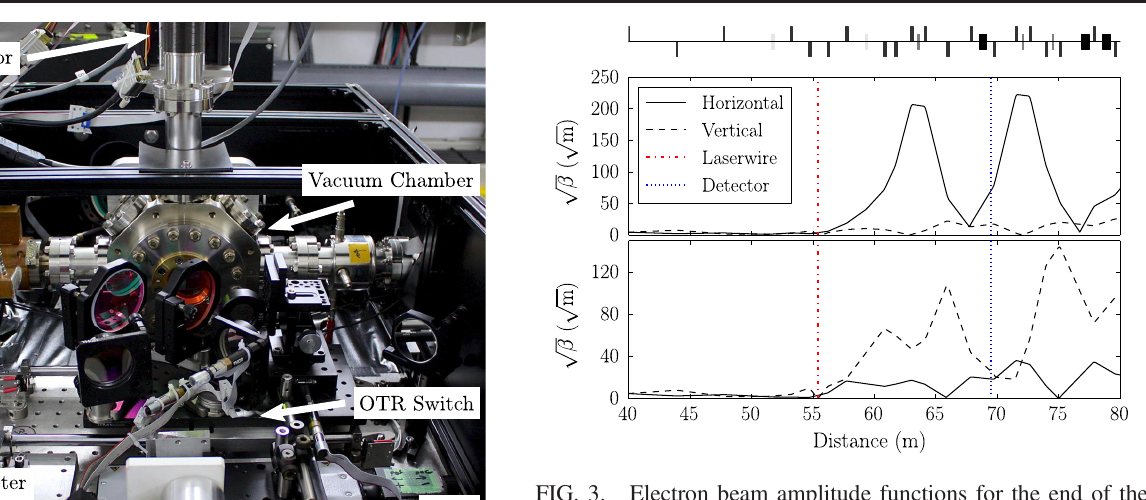
FIG. 3. Electron beam amplitude functions for the end of the extraction line, matching section and beginning of the final focus section. These are shown for normal ATF2 operation (top) and for laserwire operation (bottom). The laserwire and laserwire de- tector locations are shown by (red) dot-dashed and (blue) dotted vertical lines, respectively.